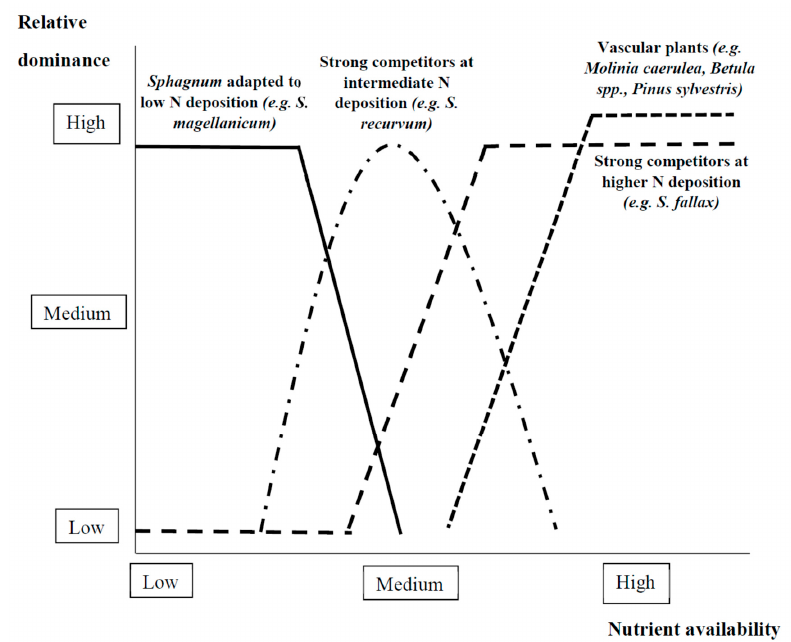
Figure 6. Examples of relationships observed in the literature reviewed between relative dominance of different foundation species and nutrient availability in boreal and temperate wetlands (see Section